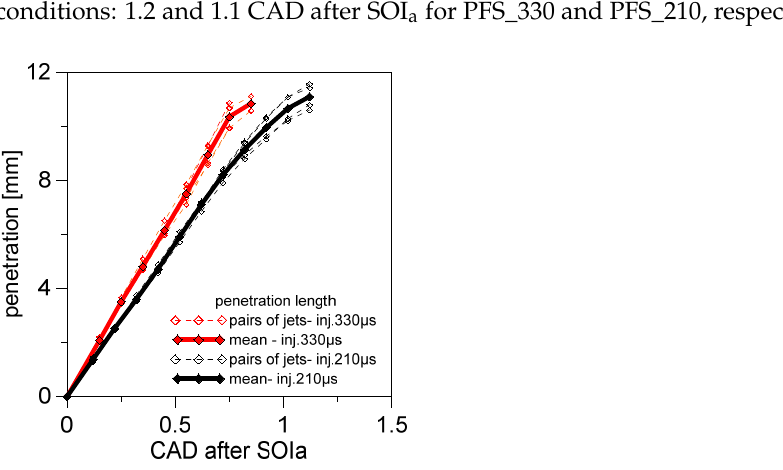
Figure 14. Directions for fuel spray penetration evaluation (left) and penetration length (right) obtained for all visible jets.